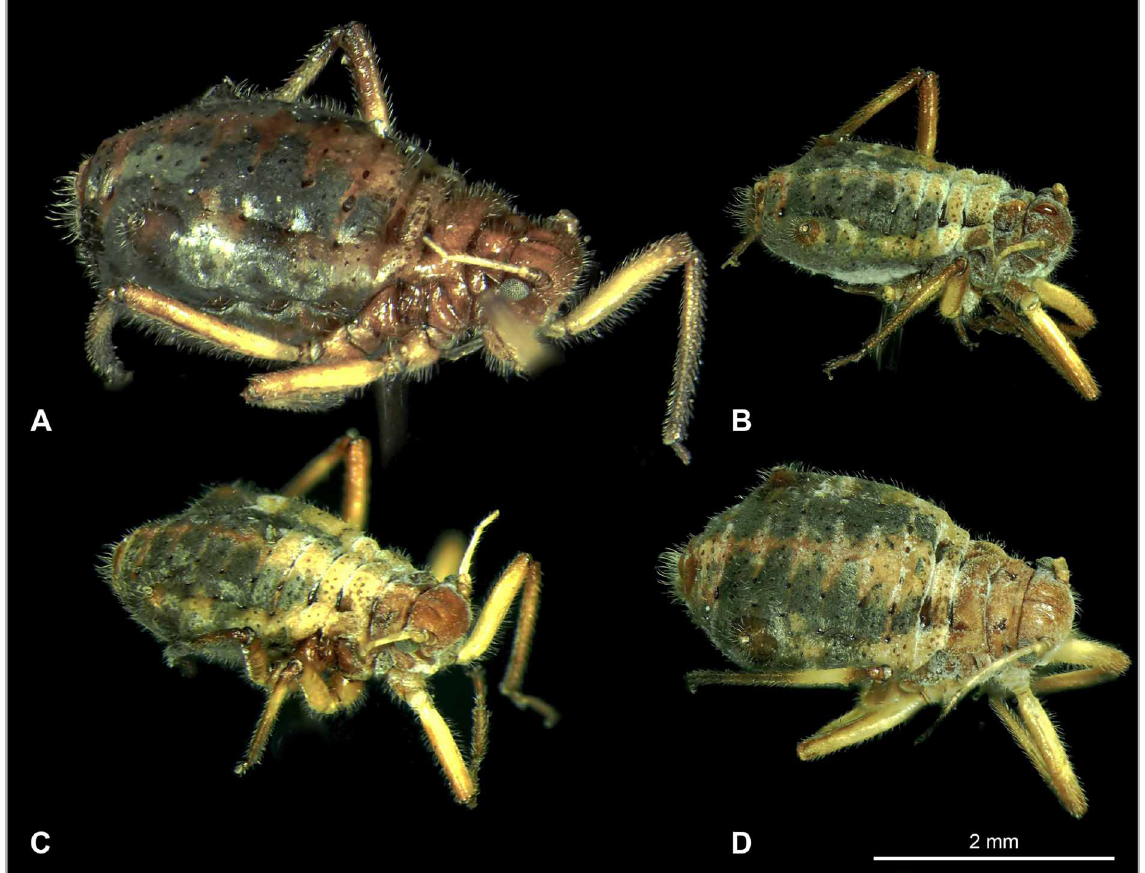
Fig. 104. Cinara (Cinara) piniphila (Ratzeburg, 1844). Freeze-dried